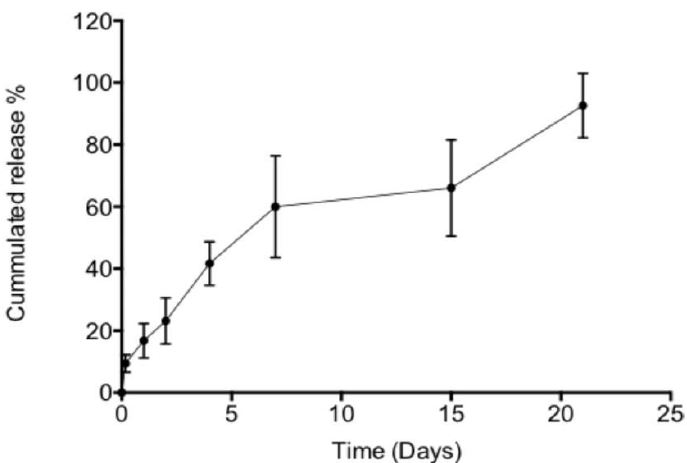
Figure 1. In vitro release of NECINH-nanoparticles (NPs) incorporated in 1% alginate hydrogel. Twenty-five microliters of NPs corresponding to 15.27 µ g of NECINH were incorporated in a 50 µ l alginate hydrogel and immersed in 40 mM CaCl 2 PBS (Phosphate buffer saline) for 21 days at 37 °C. The release was evaluated over time by fluorimetry ( n = 4).